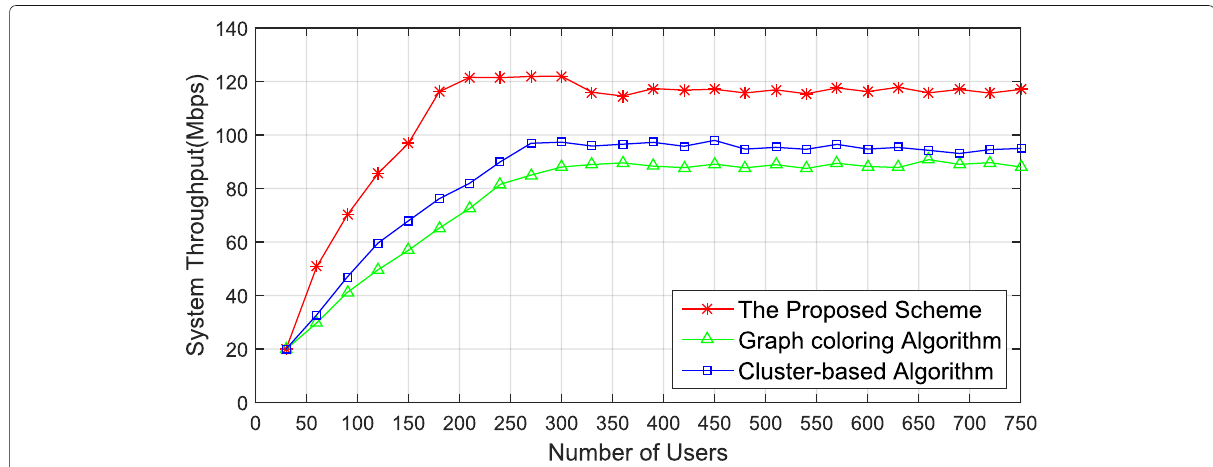
Fig. 6 Comparison of system throughput. Users include those with access and those denied access